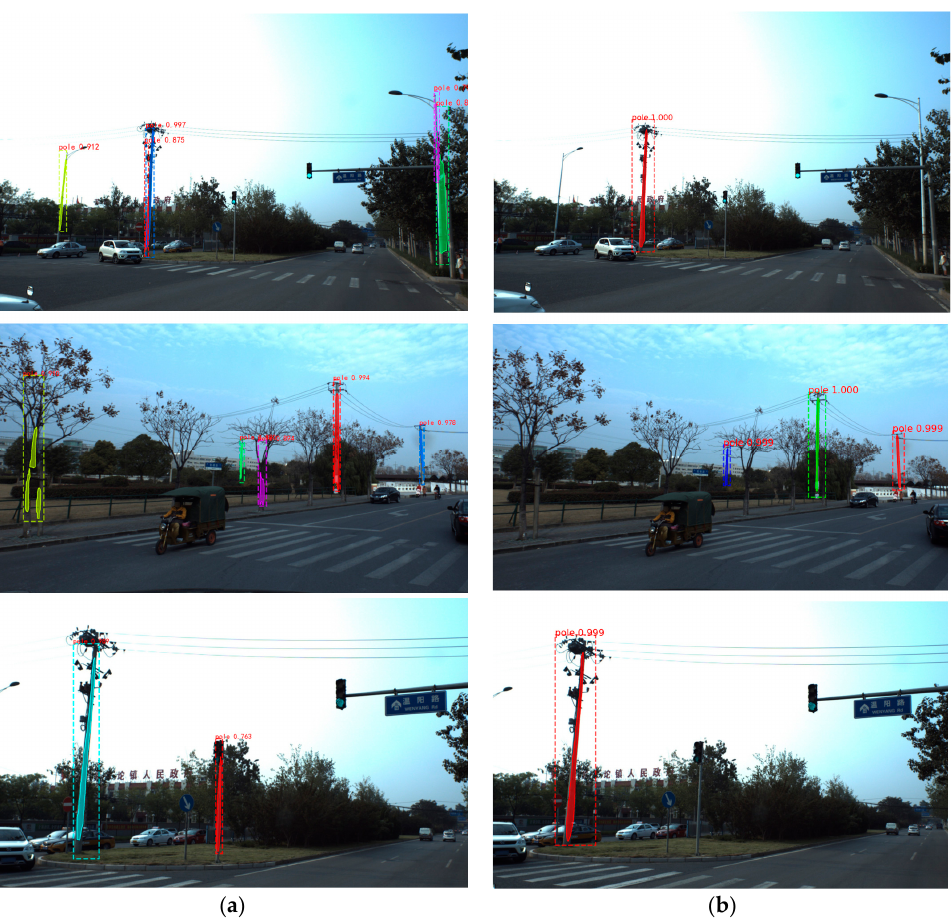
Figure 16. Visual display of original and improved effects. ( a ) Original Mask R-CNN segmentation effect; ( b ) Improved Mask R-CNN segmentation effect.